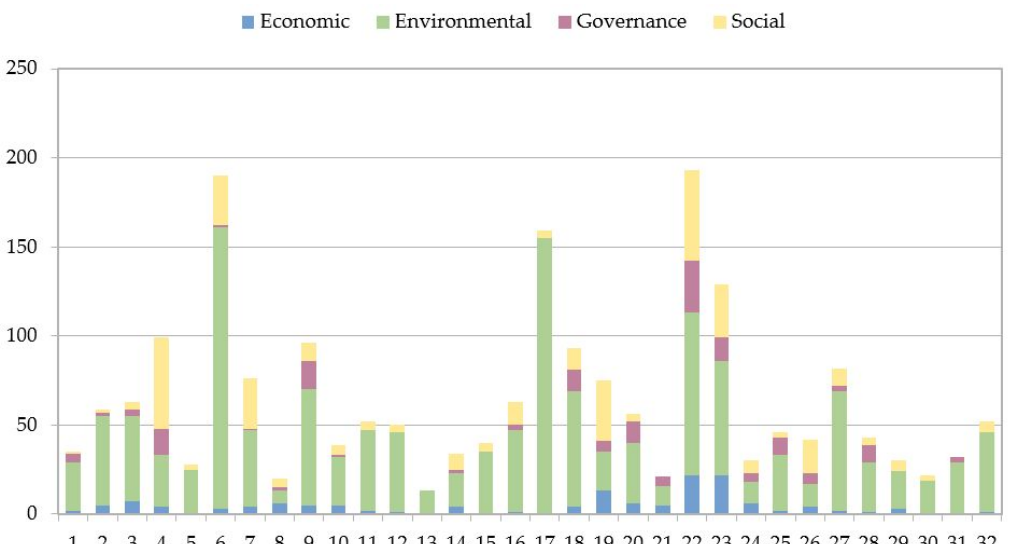
Figure 2. Distribution of considered aspects by framework.